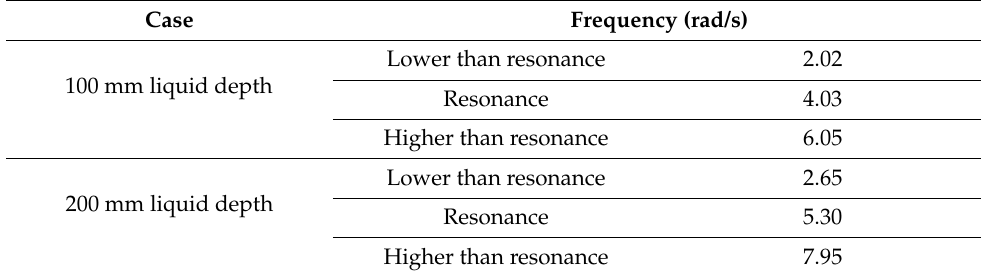
Table 1. Applied frequencies for harmonic excitations.